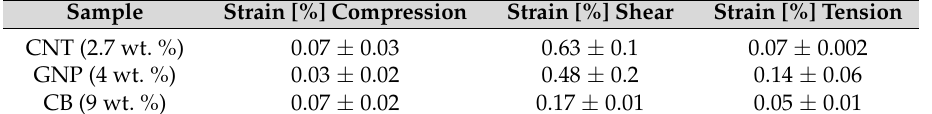
Table 2. Test specimen deformation until the first signal reply of nanostructured sensor fiber using different carbon fillers (CNT, GNP, CB) embedded in the planes of maximum stresses for compression, shear and tension, during a quasi-static three-point bending test.